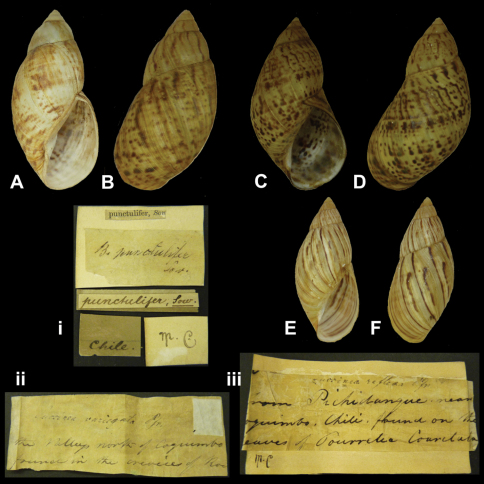
Plectostylus species. A–B, i
Plectostylus punctulifer (Sowerby I, 1833), syntype NHM 1975171 (H = 46.5) C–F
Plectostylus broderipii (Sowerby I, 1832) C–D, iii Lectotype of Bulimus variegatus Pfeiffer, 1842 NHM 1975362 (H = 46.0) E–F, ii Lectotype of Bulimus reflexus Pfeiffer, 1842 NHM 12975358 (H = 36.9).